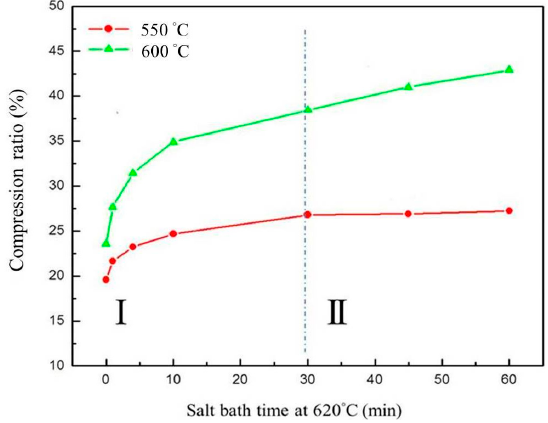
Figure 15. Relationship between compression ratio, salt bath duration, and salt bath temperatures.